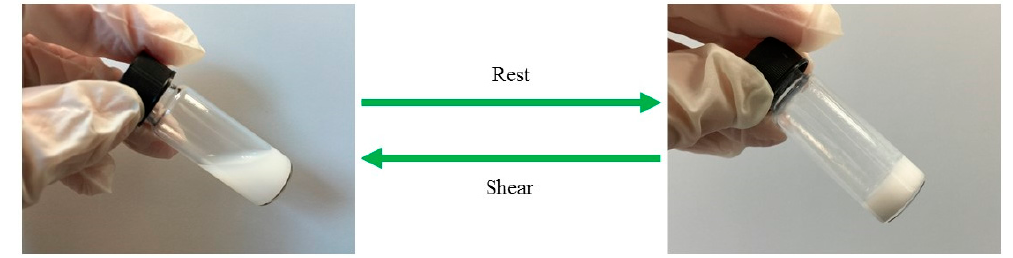
Figure 13. Thixotropic behavior of pectin-PEGMA/ α -CD hydrogels.